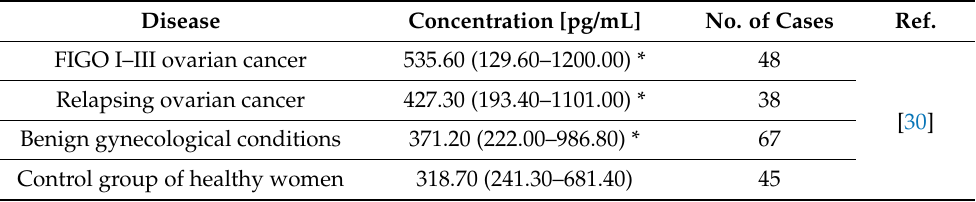
Table 8. Concentrations of monocyte chemotactic protein-1 (MCP-1) in blood serum. Disease Concentration [pg/mL] No. of Cases Ref. FIGO I–III ovarian